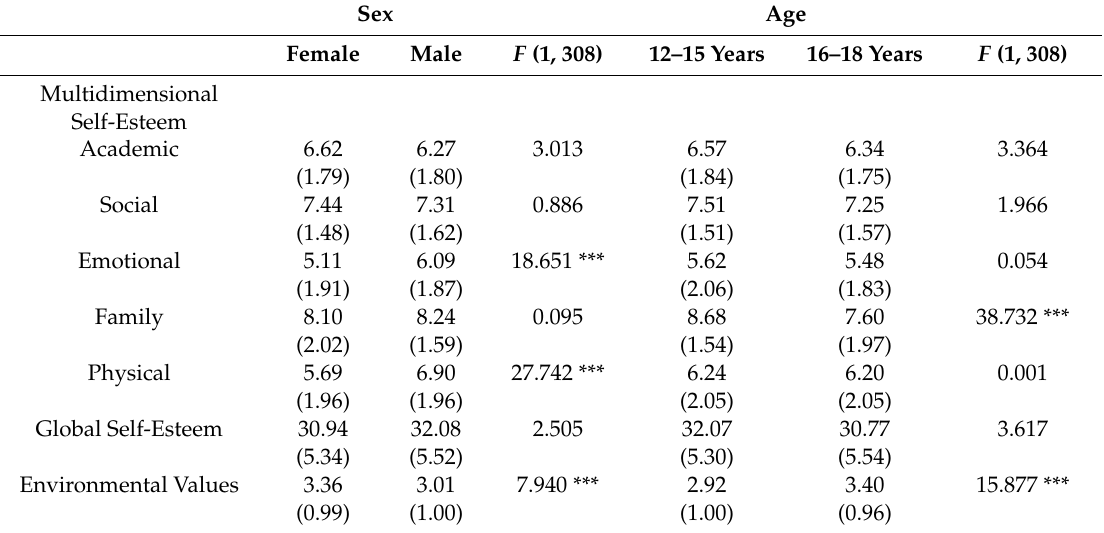
Table 4. Means, standard deviations (in parenthesis), F # values for sex and age on self-esteem and environmental